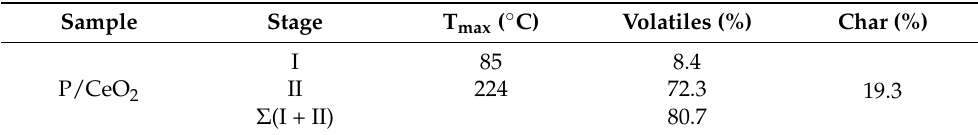
Table 5. Pyrolysis yields for TGA pyrolysis of P/CeO2 (0.6 mmol/g).